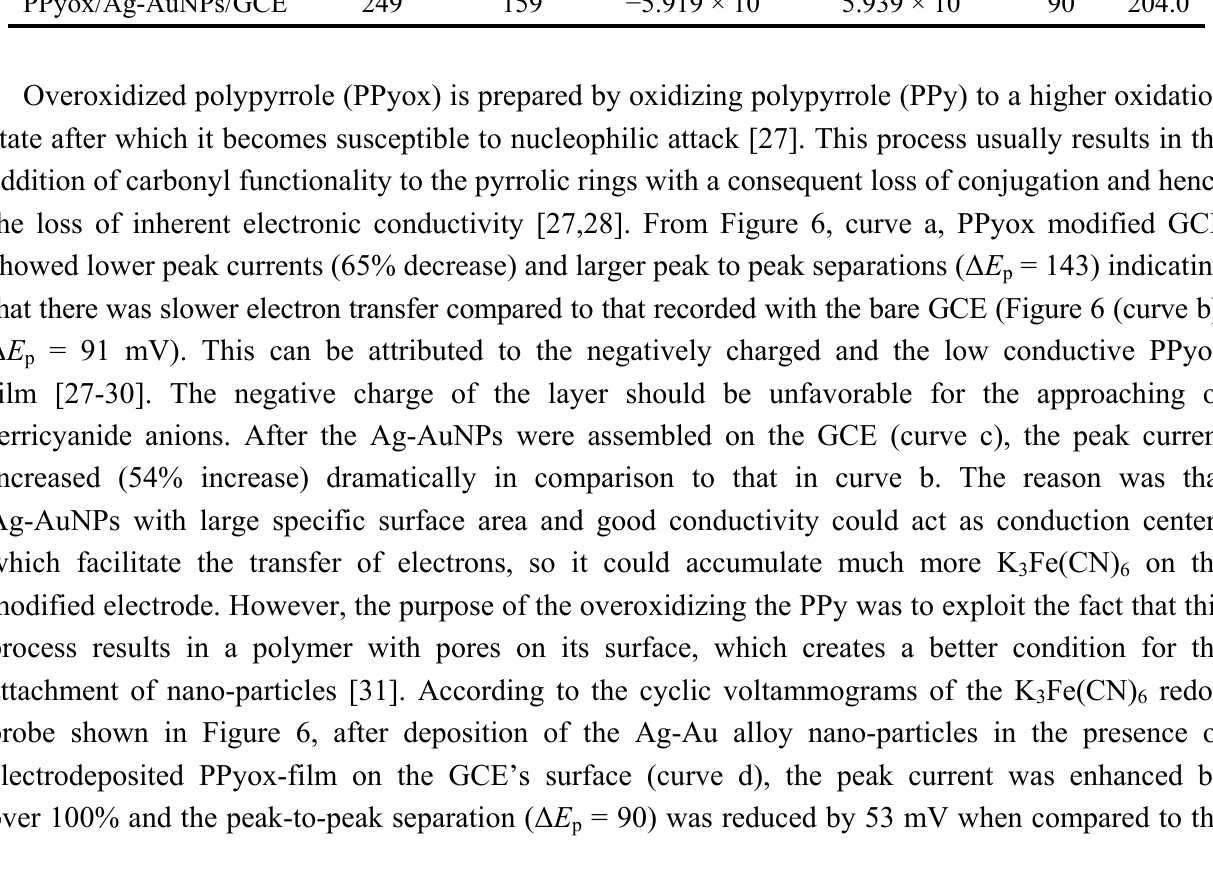
Fe(CN) solution containing 0.1 M KCl. 3 6